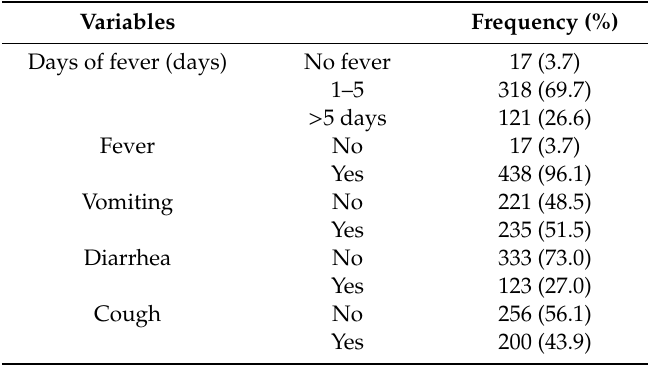
Table 2. Sign and Symptoms for leptospirosis (n =